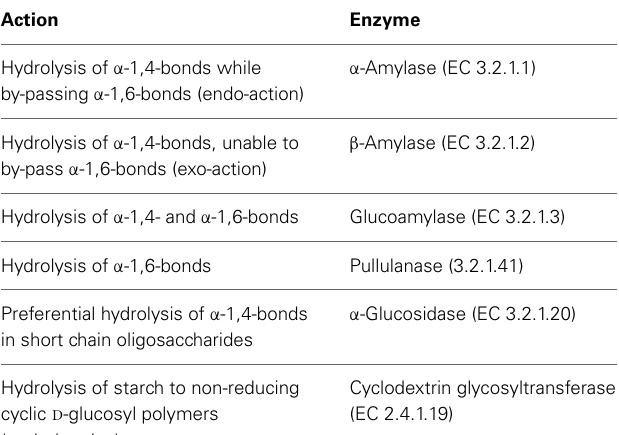
Table 2 | Hydrolytic action on starch and related polysaccharides and enzyme (Aiyer,